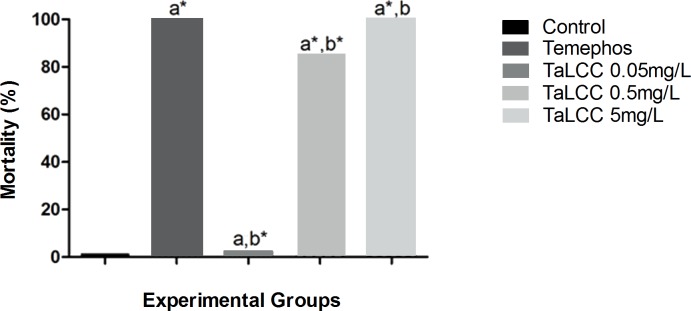
Mortality of larvae at the end of treatment exposure.Treatment exposures were statistically compared to the negative control (a) and the positive control (b). * Significant difference (chi-square test, p <0.05).